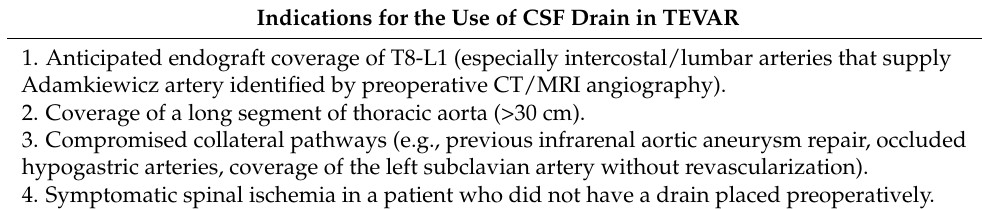
Table 3. Indications for positioning CSF drainage in patient undergoing TEVAR 1 . Indications for the Use of CSF Drain in